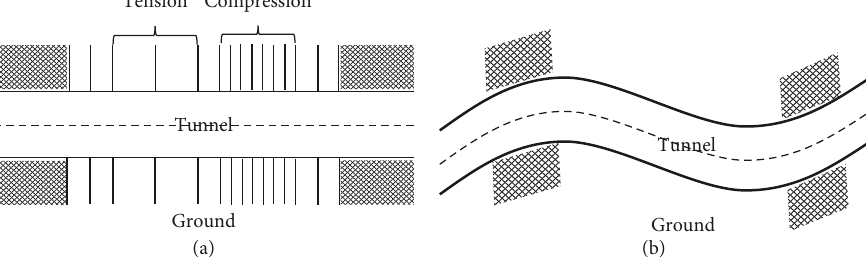
Figure 2: Deformation modes of tunnels due to seismic waves. (a) Longitudinal direction and (b) transverse direction.